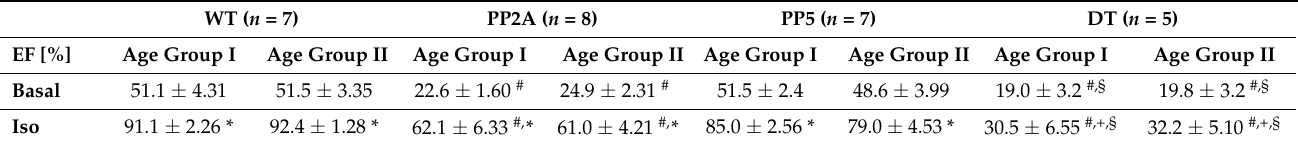
Table 2. Ejection fraction (EF) estimated by echocardiographic under basal conditions and after β -adrenergic stimulation by isoproterenol (Iso) in young 3–4 months old mice (age group I) compared to the middle-age 10–11 months old mice (age group